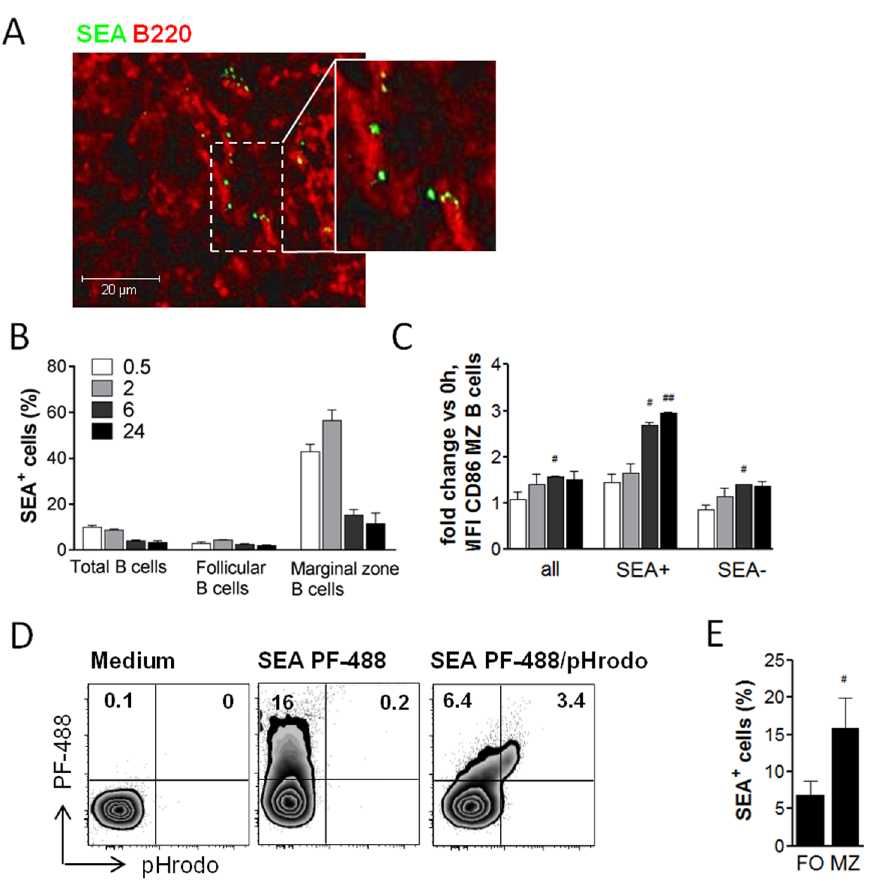
Fig 4. Schistosome antigens bind to B cells and are internalized into acidic compartments. (A) C57BL/ 6 mice were i.v. injectedwith 200 μ g of fluorescently labeledSEA and spleenssnap-frozen30 minutes later. Fluorescence microscopicimage shows localization of SEA to B220 + B cells and is representative for 2 experiments with N = 5 mice and 3 viewingfields per section imaged. (B, C) Splenic B cells were analyzedby flow cytometry at 30 minutes to 24 hours after i.v. injectionof labeledSEA for (B) frequencyof SEA + cells within total B cells or B cell subsets as gated in Fig 2A, and for (C) fold increaseof CD86 expressionon total MZ B cells comparedto MZ B cells gated for SEA + and SEA - populations. Summary of 2 experiments with N = 2. (D, E) Splenic B cells from na ï vemice were cultured in vitro with SEA (20 μ g/ml) labeledwith a green dye (PF-488) alone,or co-labeled with a pH-sensitive dye (pHrodoRed). After 60 minutes, the frequencyof SEA + B cells was determined by flow cytometry. (D) Gated for total CD19 + B cells (1 representative out of 2 experiments shown). (E) Gated for follicular(FO) and marginalzone (MZ) B cell subsets (summary of 3 experiments). Significant differences indicatedwith # p < 0.05 and ## p < 0.01 are determinedby one-sample t- test of log-transformed data (C) or betweenB cell subsets by Wilcoxon